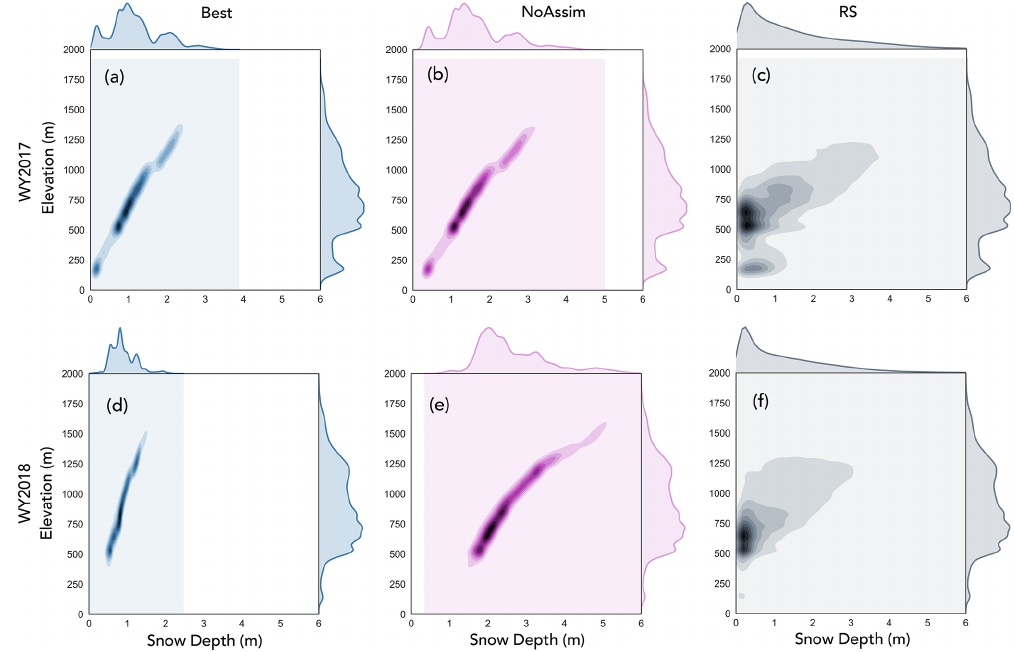
Figure 9. The 2D histograms showing the elevation data set vs. the (a) water year (WY) 2017 best assimilation case, (b) WY2017 no assimilation case, (c) WY2017 RS data set, (d) WY2018 best assimilation case, (e) WY2018 no assimilation case, and (f) WY2018 RS data